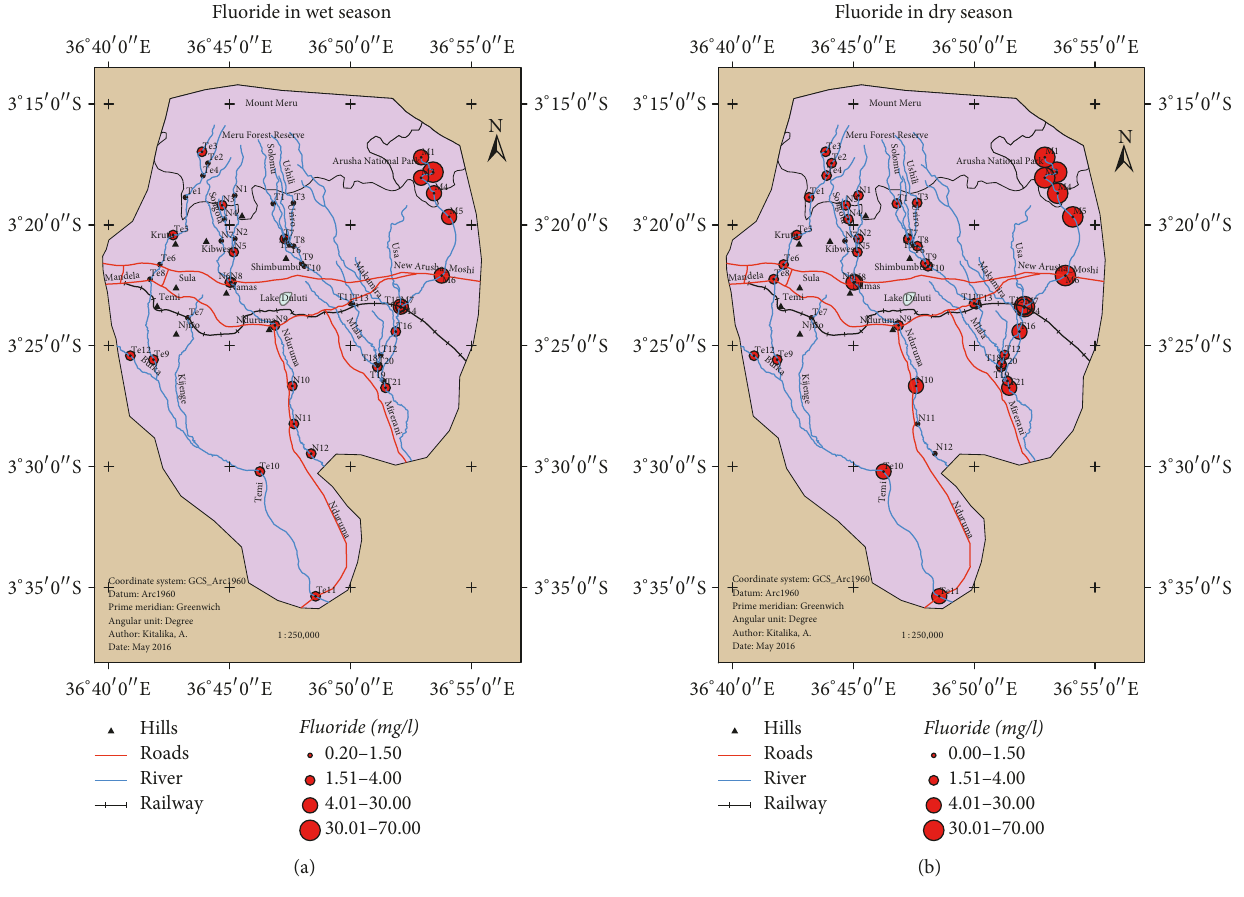
Figure 4: Fluoride variation in wet (a) and dry (b)